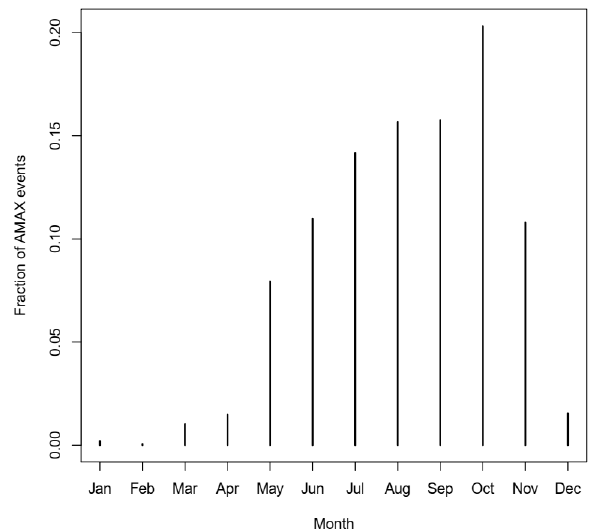
Figure 3. Fraction of annual maxima precipitation events across Vietnam classified into each calendar month. The period from July to October, in which about two-third of annual maxima precipitation events are concentrated, was used to derive yearly time series of climate indices.